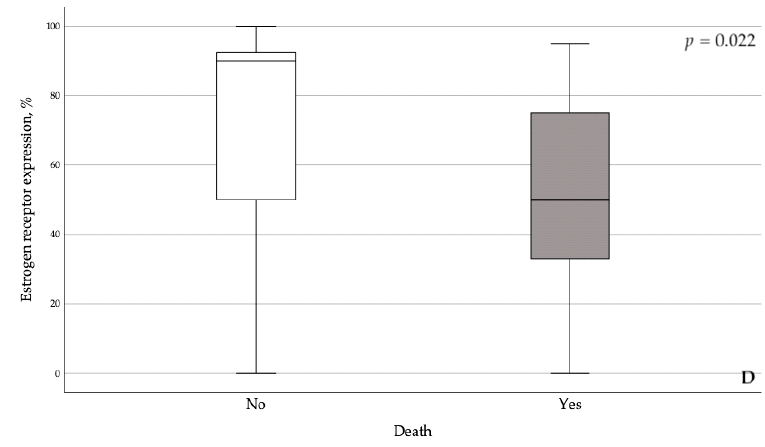
Figure 1. Correlation between progesterone and estrogen receptors expression, and relapse and death. The majority of women in the cohort had a protein score of 3 for LRIG1 (97.3%) (Table